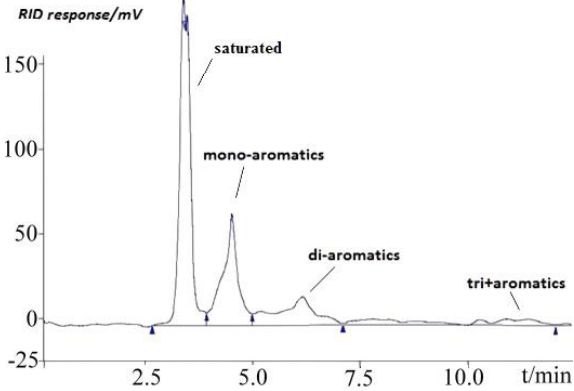
Figure 4. HPLC chromatogram of pyrolytic oil and diesel fuel mixture